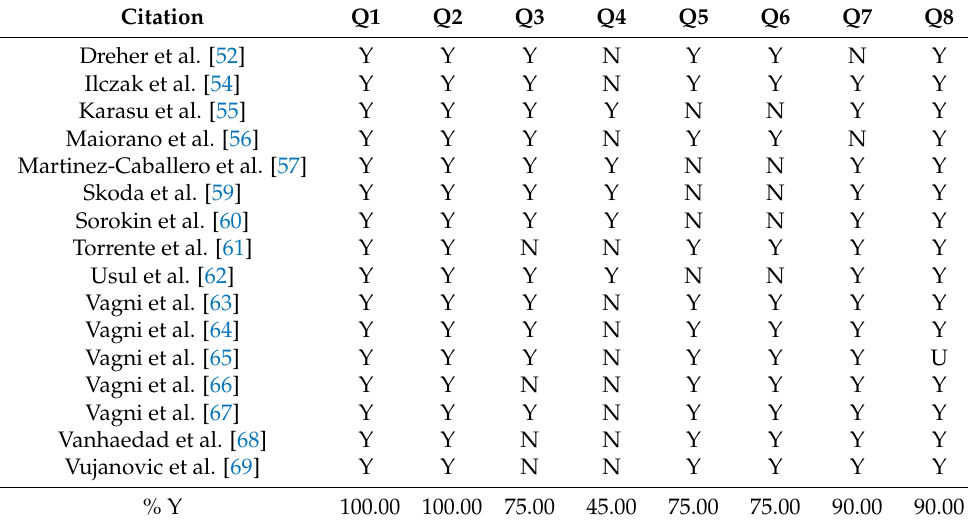
Table 3. Critical appraisal of cross-sectional studies.